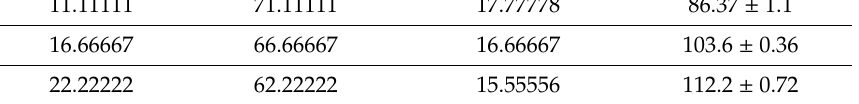
Oil % Surfactant % Co-Surfactant % DS (nm) Diagram 6: Octanoic acid, Tween 20 ® , and Transcutol HP ® at a Smix ratio of 4:1